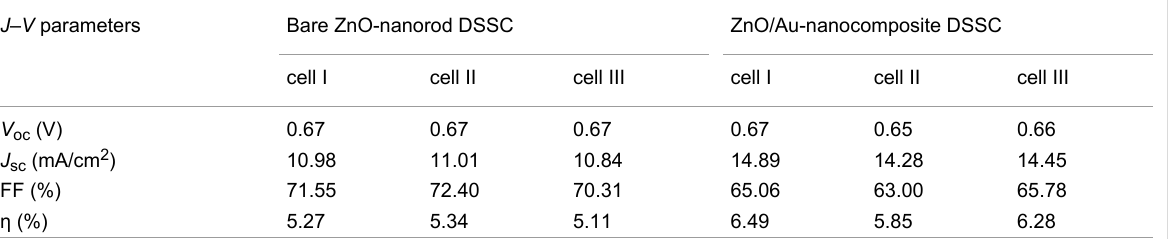
Table 2: J–V characteristics of bare ZnO-nanorod and ZnO/Au-nanocomposite DSSCs measured at 1 sun, AM 1.5 G illumination (100 mW/cm 2 ). a